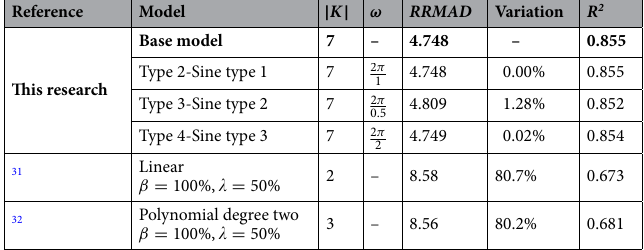
Table 5. Comparing main models with other models. Significant values are in bold.